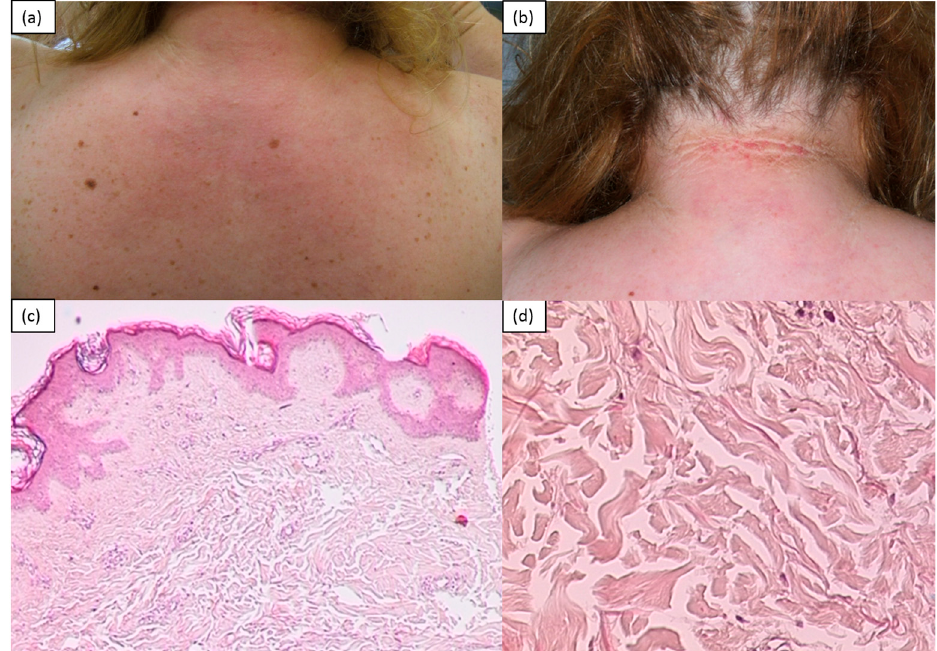
Figure 5. A 53-year-old female patient reported difficulty breathing, forearm cramps and calf tenderness concomitant with the appearance of induration of the skin of the posterior and lateral parts of the neck, which gradually extended to the upper back and shoulders ( a , b ). H&E specimen of the skin (original magnification: 50×) showed unusual thickness of the dermis ( c ), increased thickness of collagen fibers and presence of optically empty spaces between the bundles of fibers (original magnification: 200×) ( d ).